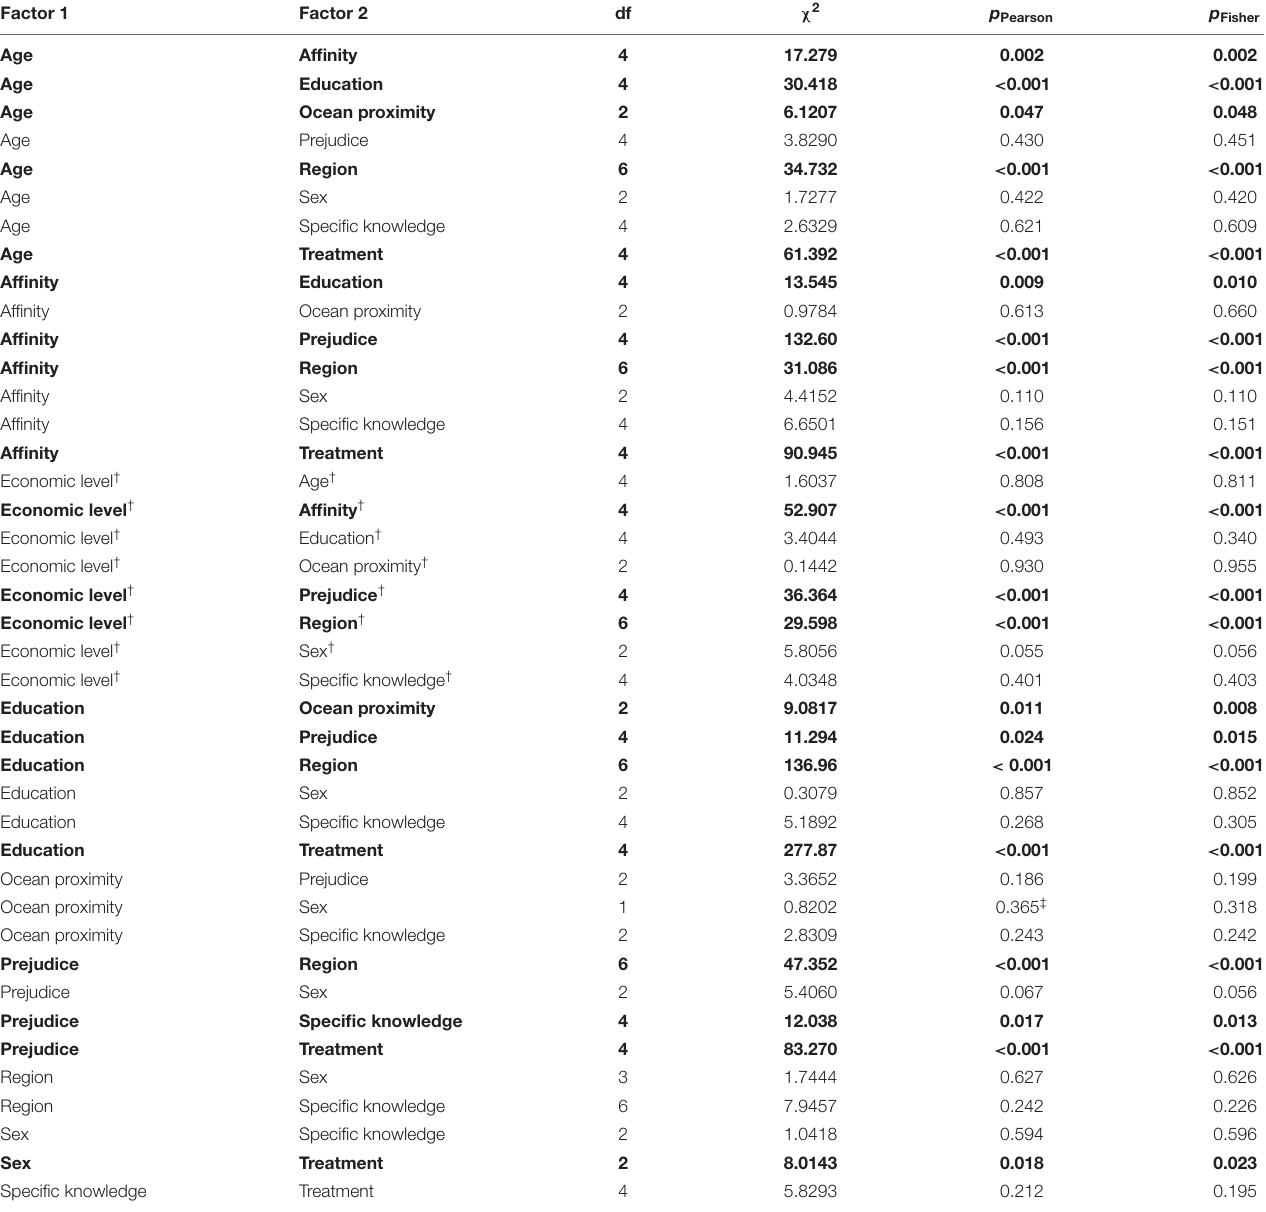
TABLE 1 | Pearson’s χ 2 test and Fisher exact test results for pairwise combinations of factors to assess their